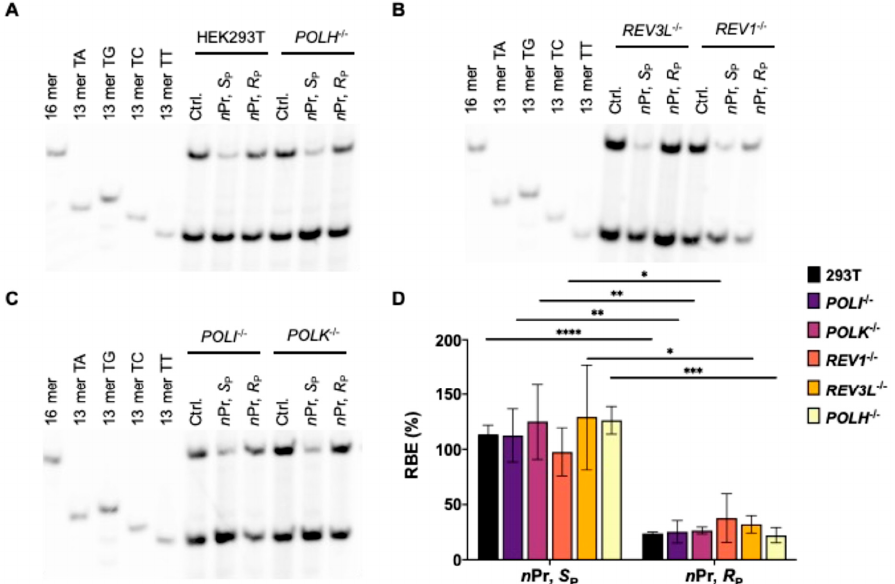
Figure 3. Transcriptional bypass of n Pr-PTE in HEK293T cells and isogenic cells depleted of TLS polymerases. ( A – C ) Gel image showing the 16 mer (from the competitor genome) and 13 mer (from the control or lesion-containing genome) digestion products formed from the original template strand, where 13 mer TG/TA/TC/TT designate [5 ′ - 32 P]-labeled stand- ard ODNs 5 ′ -CATGGCMNGCTAT-3 ′ , with ‘MN’ being TT, TG, TC and TA, respectively. ( D ) The RBE values of the two diastereomers of n Pr-PTE lesions in HEK293T cells and isogenic cells depleted of TLS polymerases. The data represent the means ± S.D. (n = 3). *, 0.01 < p < 0.05; ***, 0.0001< p < 0.001; ****, p < 0.0001. The p values were calculated by using Sidek’s multiple comparisons test.